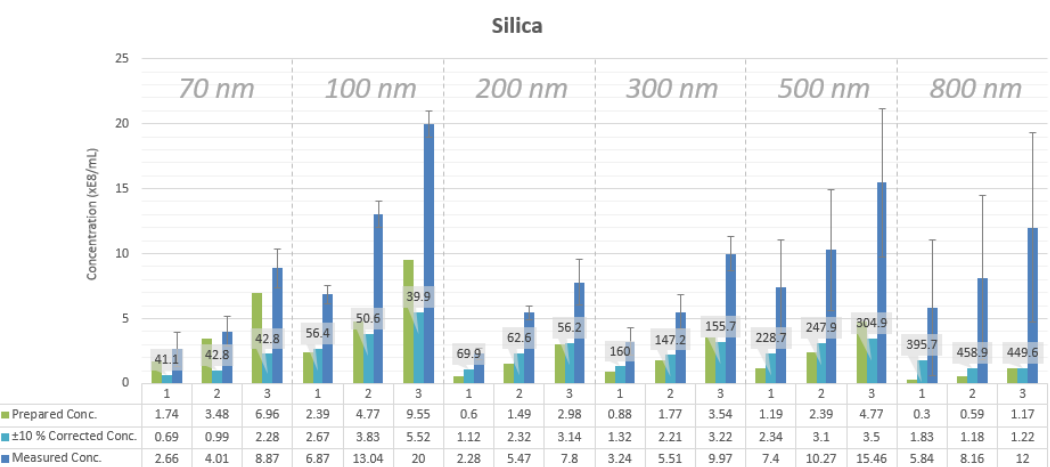
Figure 3. Concentration measurements of three prepared concentrations for different particle sizes for silica nanoparticles as measured by NTA. Each sample of nanoparticles is measured in triplicate by three different researchers on three separate occasions, adding up to nine measurements for each sample. The ± 10% corrected concentrations represent a cut percentage of the measurement histograms. More on this can be found in Section 2.3. FWHM values for sample histograms are shown in nm in data